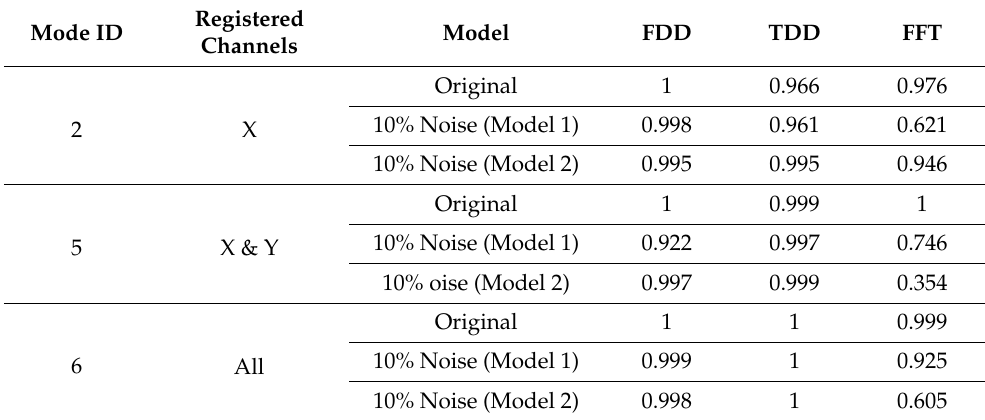
Table 3. MAC values between calculated and theoretical mode shapes using different methods.